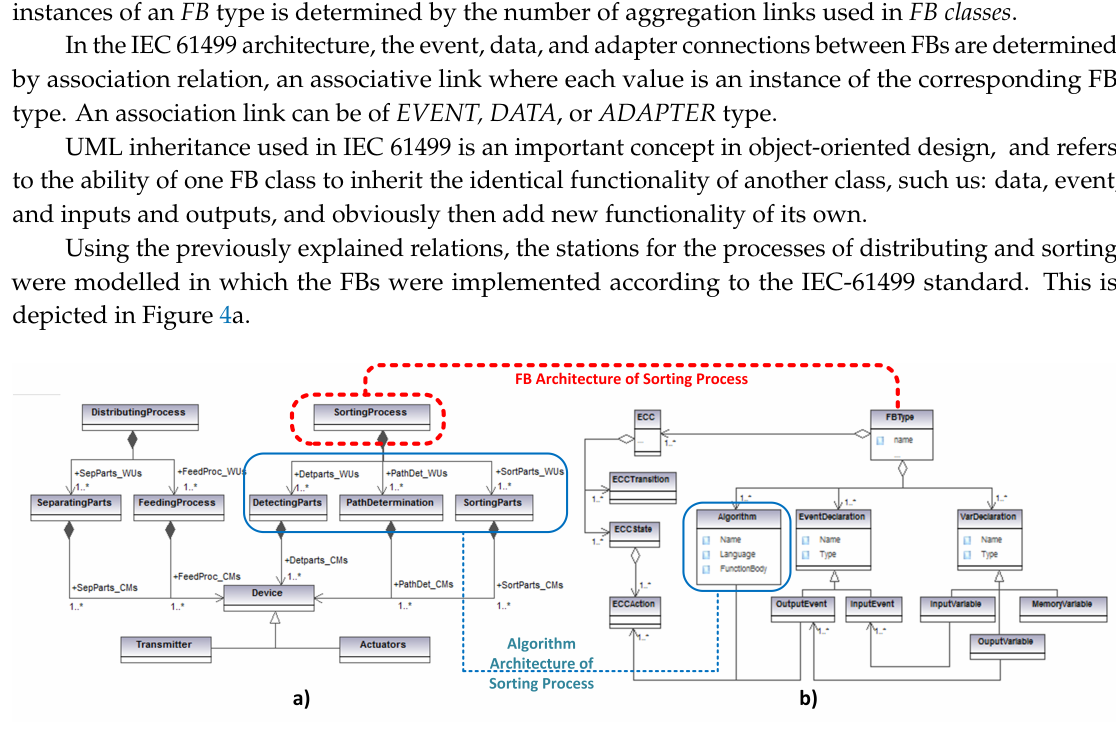
Figure 4. Unified Modeling Language (UML)-based architecture for ( a ) Distributing and Sorting Process, ( b ) Service Interface FBs (SIFBs). ECC: execution control